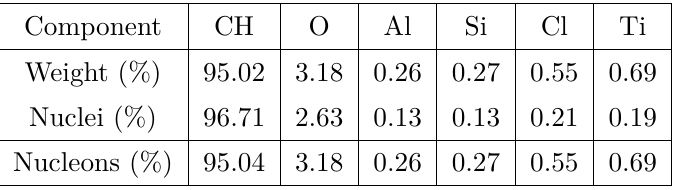
Table 1 . MINERvA target nuclear composition in weight fraction and the translation to the fractional composition in nuclei. Last row shows the fraction of nucleons of each of the spices with respect to the total. Data taken from ref. [30].